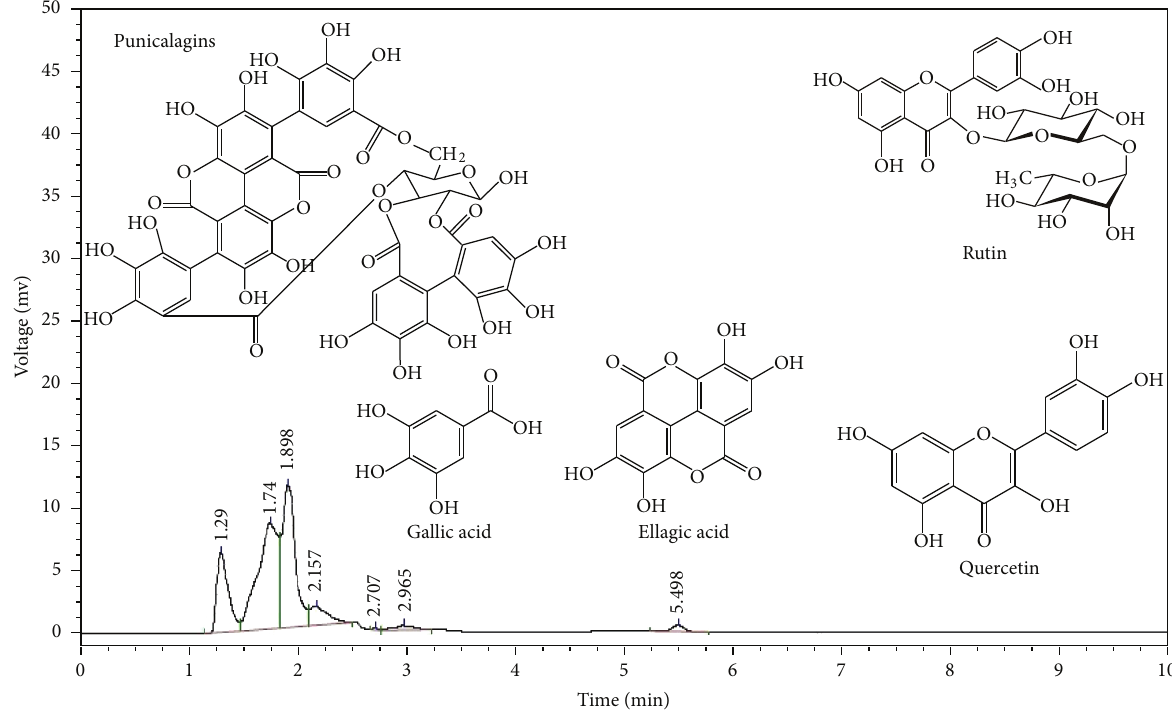
Figure 4: The Punica peels chromatograms gallic acid, rutin, quercetin, ellagic acid, and punicalagin, respectively.